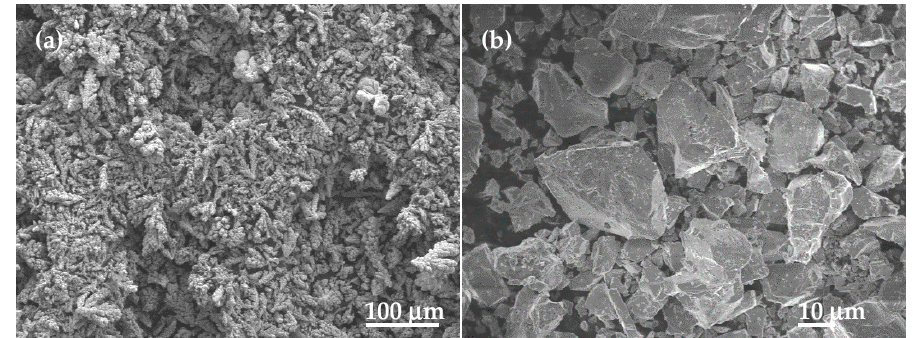
Figure 1. Scanning electron microcopy (SEM) images of starting powders of ( a ) copper and ( b ) TiH2.